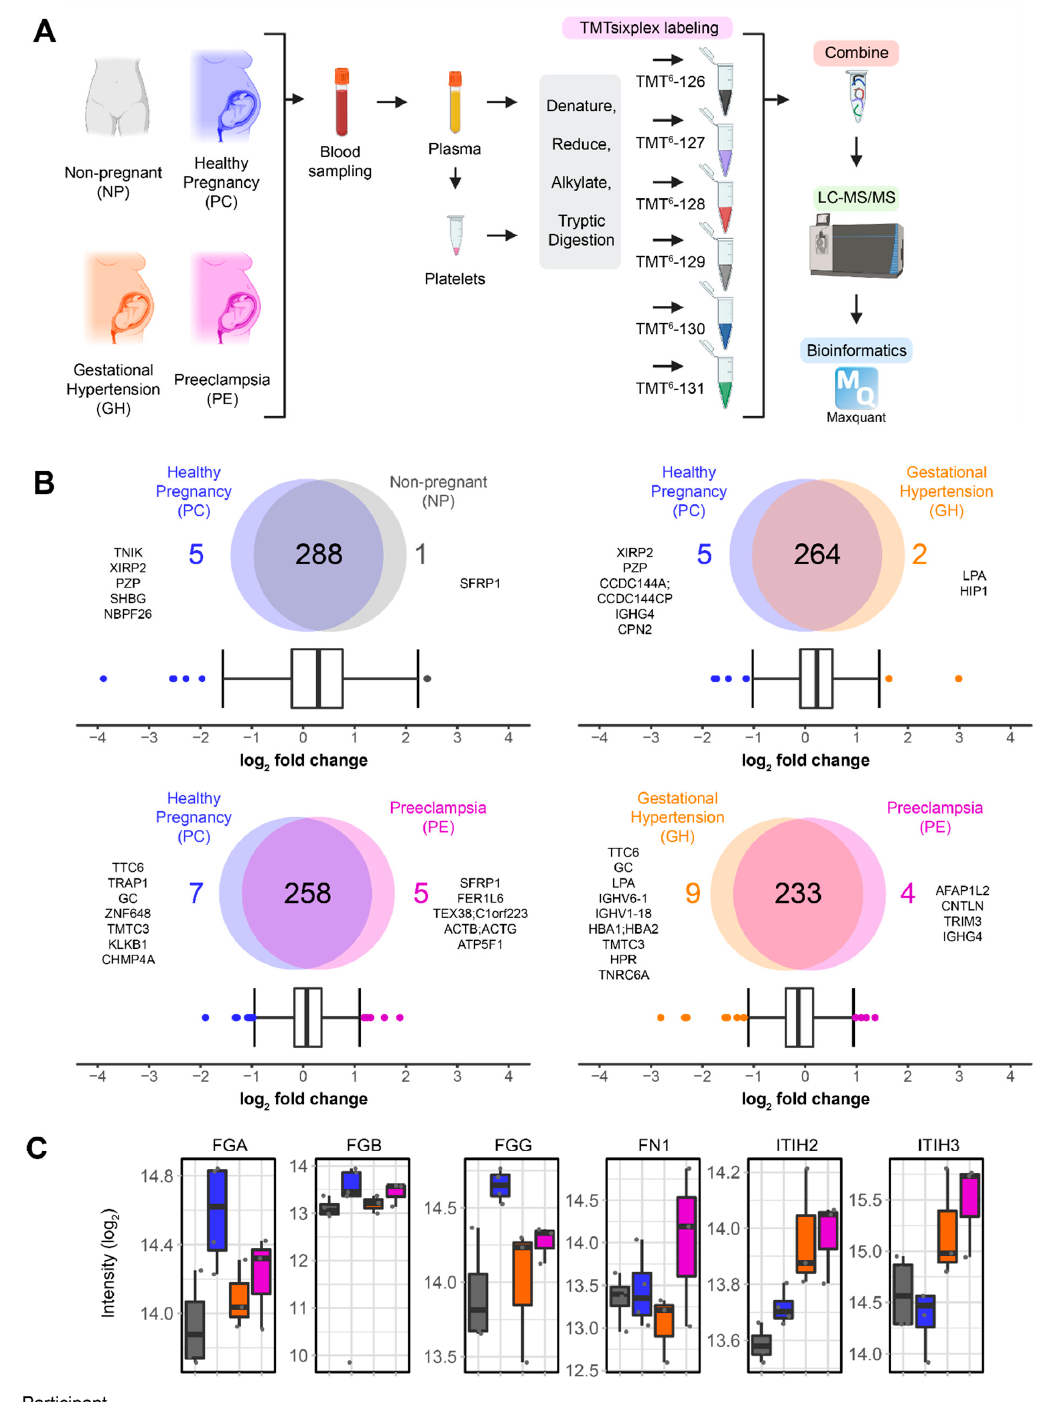
Figure 1. ( A ) Schematic of the proteomics workflow of non-pregnant (NP), healthy pregnancy (PC), gestational hypertension (GH), and preeclampsia (PE) patients. The plasma and platelets were extracted and submitted to a TMTsixplex labeling and shotgun proteomics workflow. ( B ) Quantification results of plasma proteomics and multiple group comparison as illustrated by Venn Diagrams. Interquartile boxplot analysis was performed to identify the differently expressed proteins as represented by outliers. ( C ) Fibrinogen alpha chain (FGA), fibrinogen beta chain (FGB), fibrinogen gamma chain (FGG), fibronectin 1 (FN1), inter-alpha-trypsin inhibitor heavy chain H1 (ITIH2), and -3 (ITIH3) intensity as quantified by shotgun proteomics. Data are represented as